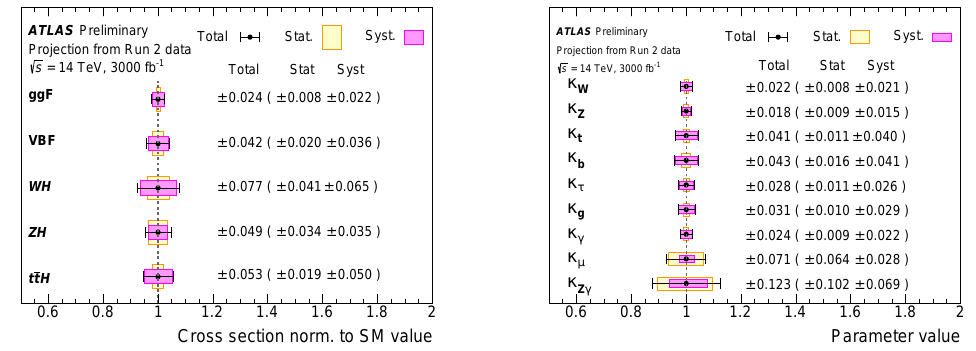
Figure 4: Higgs boson production mode measurements reach their ultimate sensitiv- ity at the HL-LHC (left), allowing for precise measurements of the couplings relative to the Standard Model (right). In this scenario, the systematic uncertainties in the measurement are assumed to be half of the current Run 2 uncertainties [ 12 ]